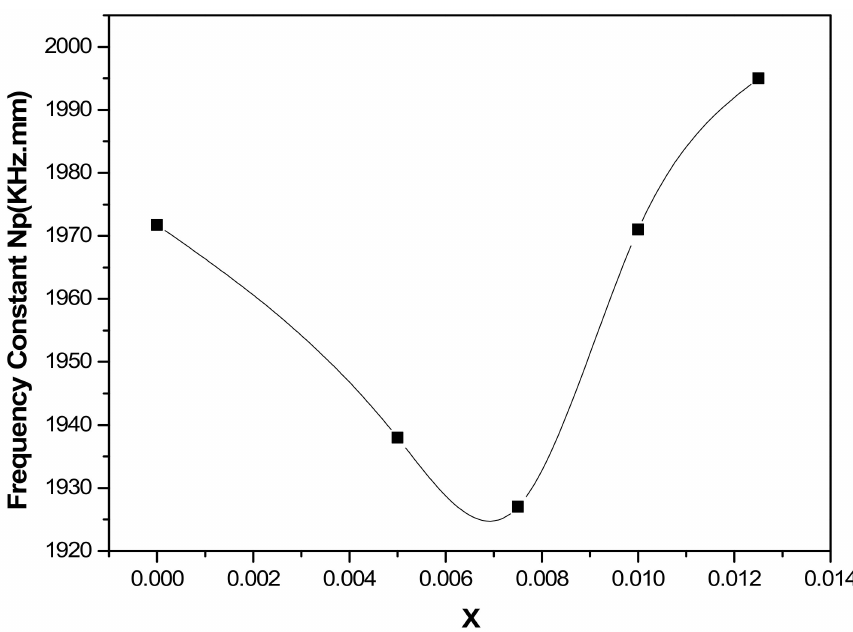
Figure 7. The variation of frequency constant Np with Sm substitution.